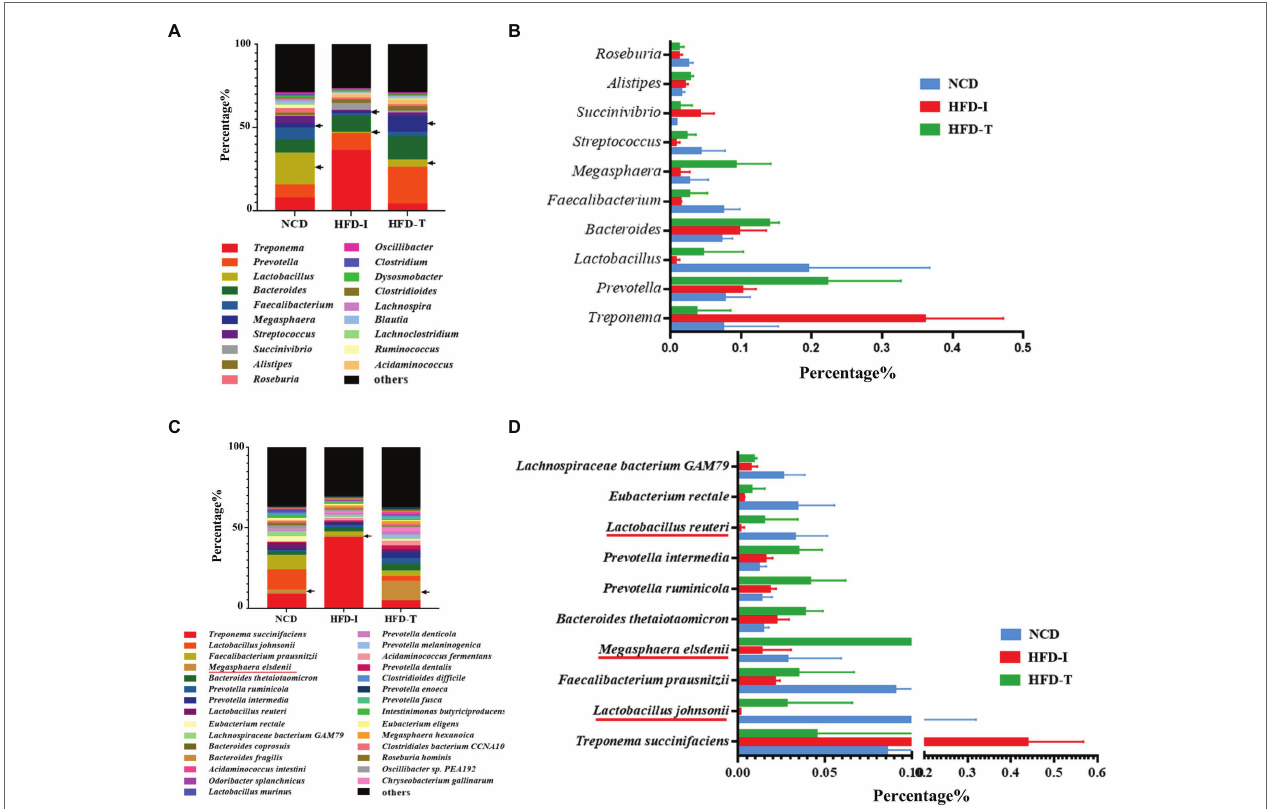
FIGURE 3 | The most abundant genera and species in the gut microbiota of NCD, HFD-I, and HFD-T monkeys. Relative abundances of the gut microbiota at the genus level (A) , top 10 abundant genera (B) , relative abundances of the gut microbiota at the species level (C) , and top 10 abundant species (D) are shown.